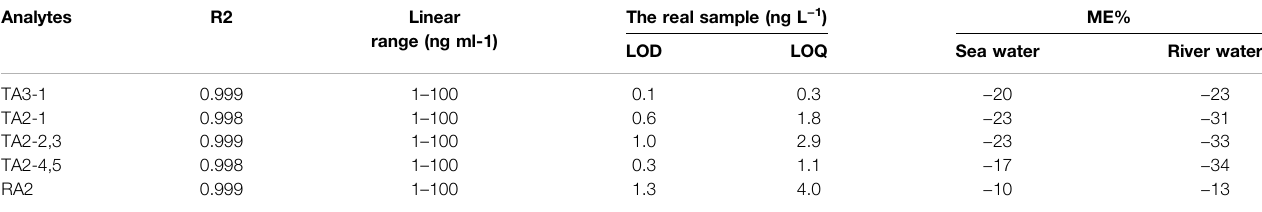
TABLE 2 | Linearity, sensitivity, and matrix effects of the developed method for analytes.